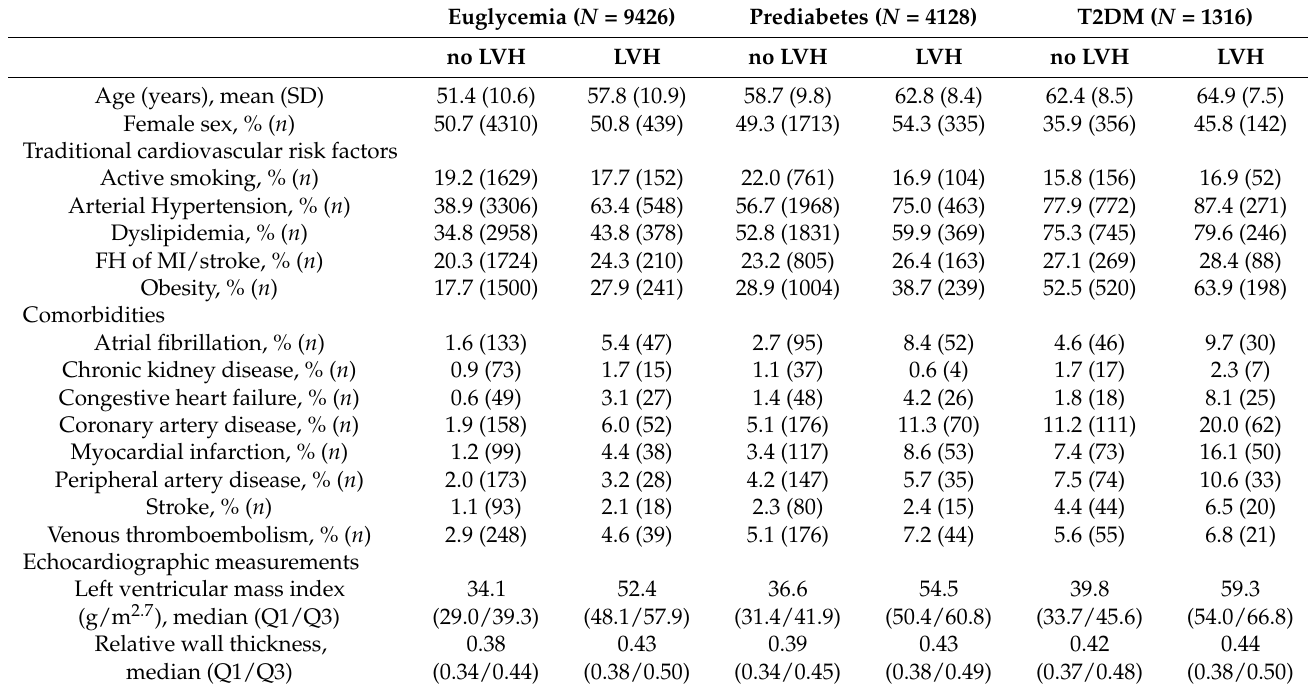
Table 1. Diabetic status and the prevalence of cardiovascular risk factors and comorbidities in people with and without LVH ( N = 14,852).